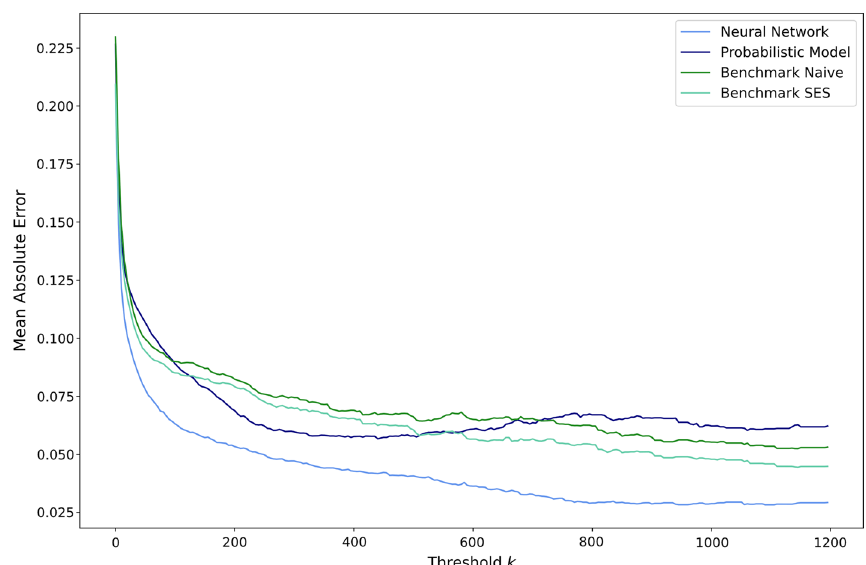
Fig. 11 MAE for different subsets of the evaluation data set. Source : Own